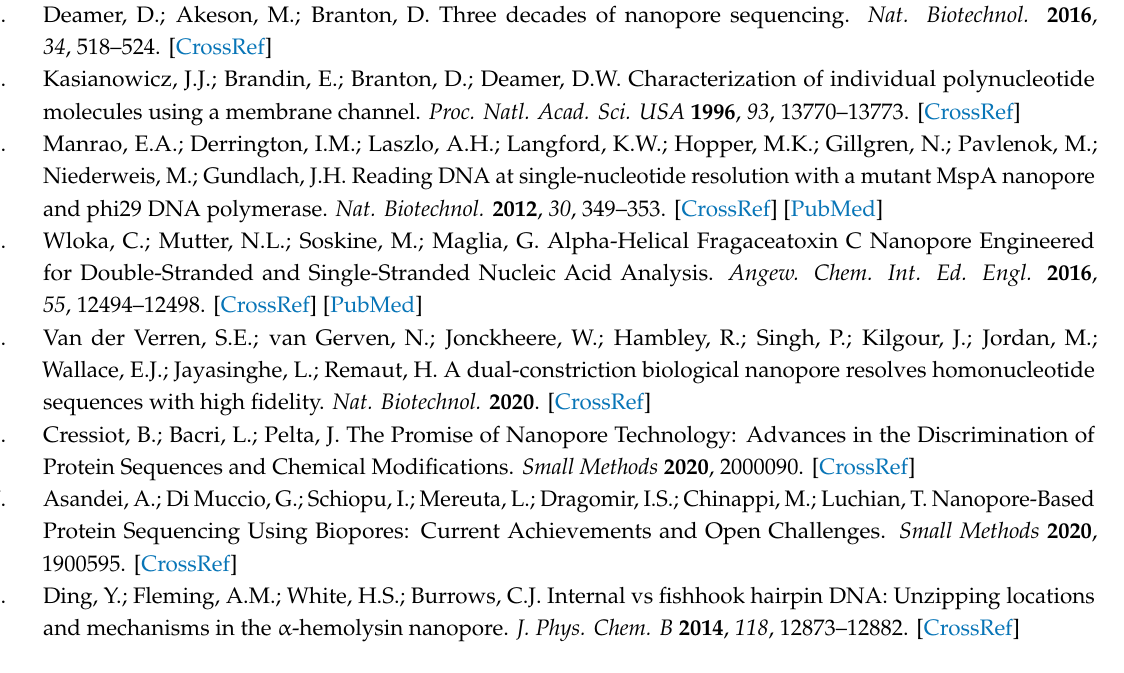
Figure S1: Distribution histograms of ∆ I / I 0 and ∆ t recorded with pore 1 at 250 mV, Figure S2: Distribution histograms of ∆ I / I 0 and ∆ t recorded with pore 2 at 500 mV, Figure S3: Distribution histograms of ∆ I / I 0 and ∆ t recorded with pore 2 at 250 mV, Figure S4: Scatter plot representing the ∆ t versus the ∆ I / I 0 recorded with the pore 2, FigureS5:Heatmaprepresentingthecorrelationbetweenthevariablescharacterizingeventsobtainedunder250mV. Figure S6: Linear regression performed with ∆ I / I 0 (response variable) and ∆ t (predictor), Figure S7: Confusion matrix representing the accuracy of classification with the support vector machine approach obtained under V = 250